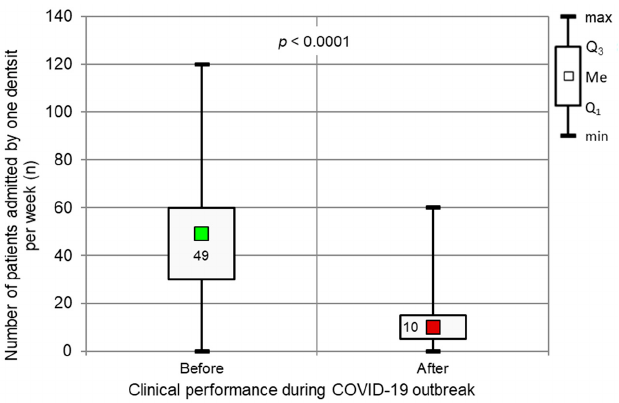
Figure 9. Number of patients admitted by one dentist per week, and clinical performance before and during a peak of the COVID-19 outbreak ( p < 0.0001, Wilcoxon